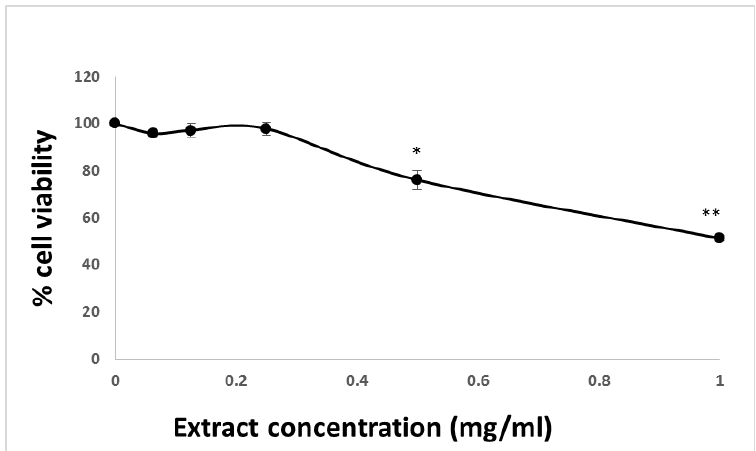
Figure 1. MTT assay of HCT-116 cells after 24 h treatment with varying concentrations of HTE. The